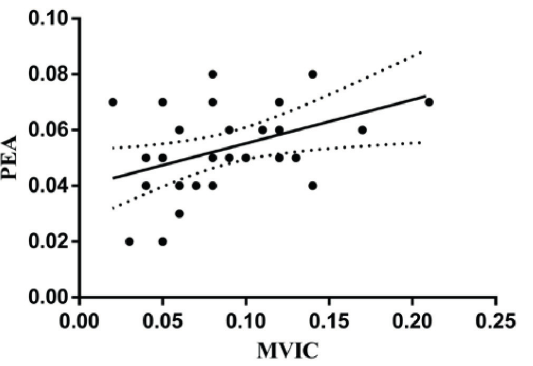
Figure 2 - Dispersion diagram and straight line of regression (with the respective 95 % confidence intervals) howing the level of co-contraction normalized by peak electrical activity (PEA) and maximum voluntary isometric contraction (MVIC) (n = 30) in gait.